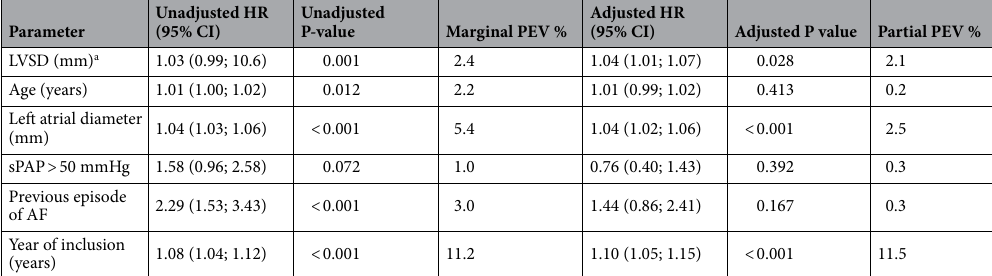
Table 2. Predictors of event-free survival. HR hazard ratio, PEV proportion of explained variation. a LVSD modelled with linear and quadratic term, HR evaluated at LVSD = 32.4